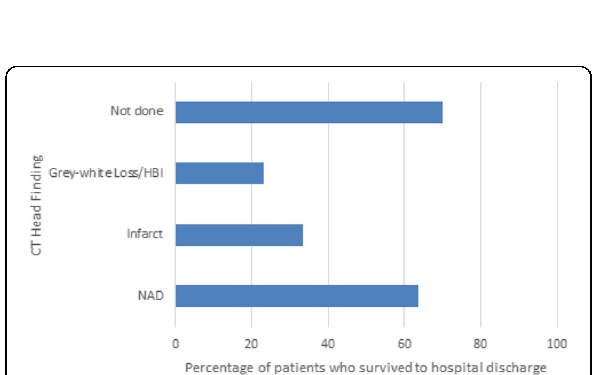
Fig. 3 (abstract 000976). The percentage of patients surviving to hospital discharge per CT head report